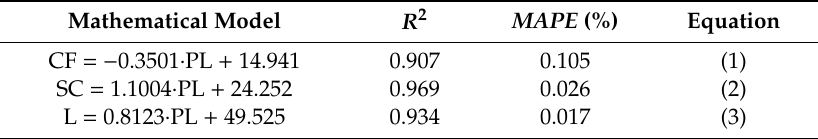
Figure 3. ( a ) Correlation of the crude fiber content (CF) of the peel residue with peel loss (PL), ( b ) correlation of the starch content (SC) of the peel residue with the peel loss (PL) and ( c ) correlation of the lightness (L) of the peel residue with the peel loss (PL) after mechanical peeling of enzyme treated cassava tubers. Table 8. Linear mathematical models of crude fiber (CF), starch content (SC) and lightness (L) values of peel residues with peel loss (PL) after mechanical peeling of enzymatically treated cassava tubers.